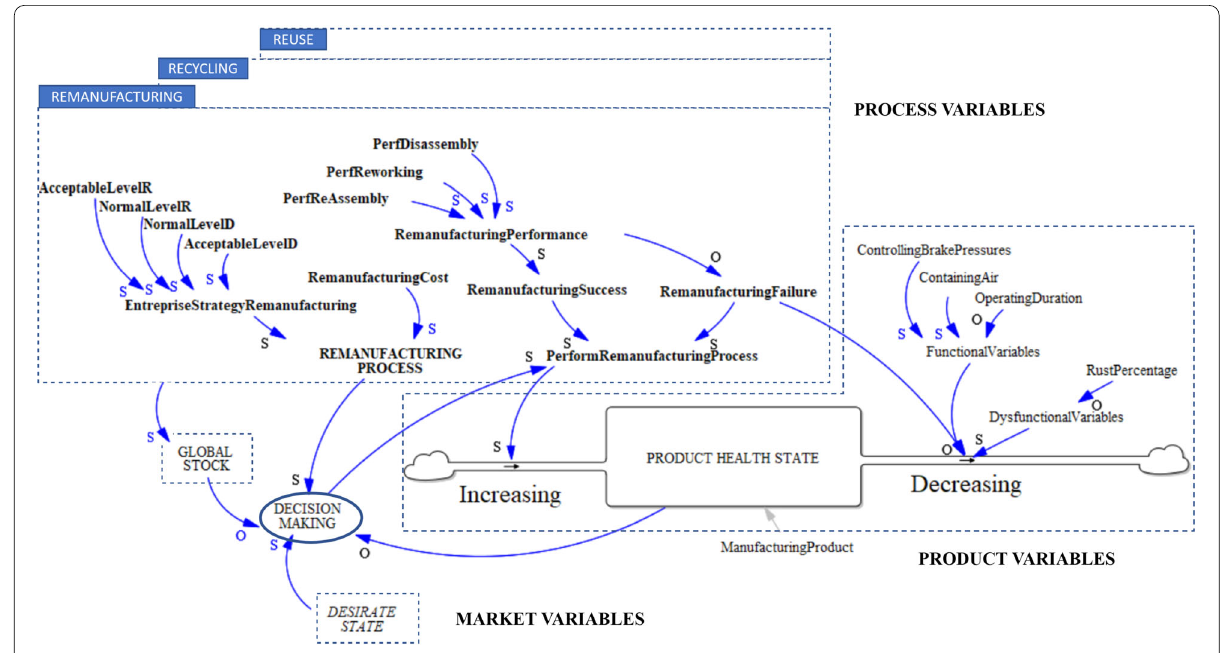
Figure 12 Causal diagram of product, process and market variables impacting decision making for EBS Module